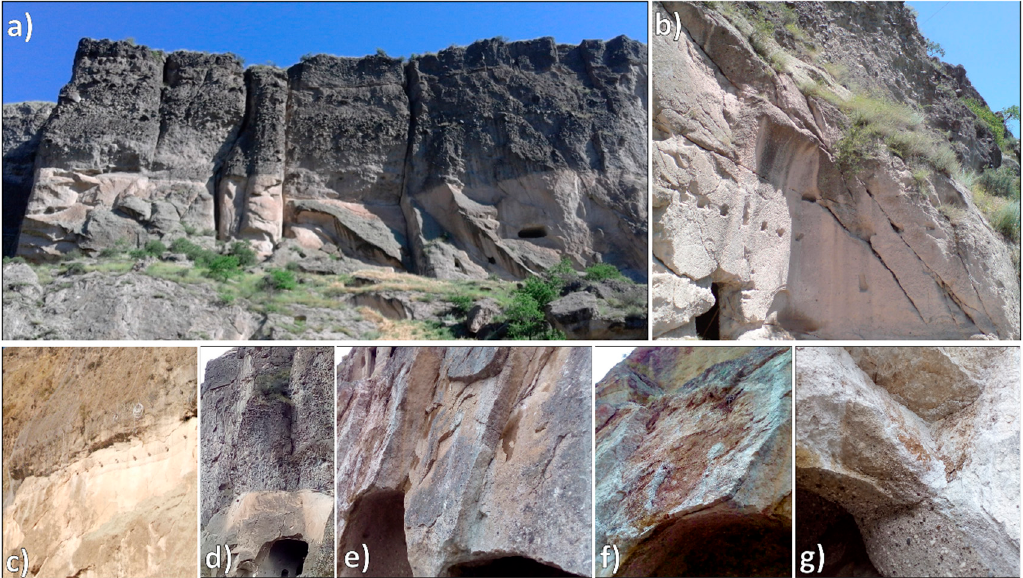
Figure 6. Vardzia slope structural setting and slope instabilities: subveritcal joint set ( a ), planar failure ( b ) direct fall ( a ) and topple ( c ) along the contact between Upper breccia and White Tuffs. White Tuffs: weathered surfaces in correspondence of planar failures ( e – f : high-angle joint set parallel to the slope) and wedge failures ( g ).